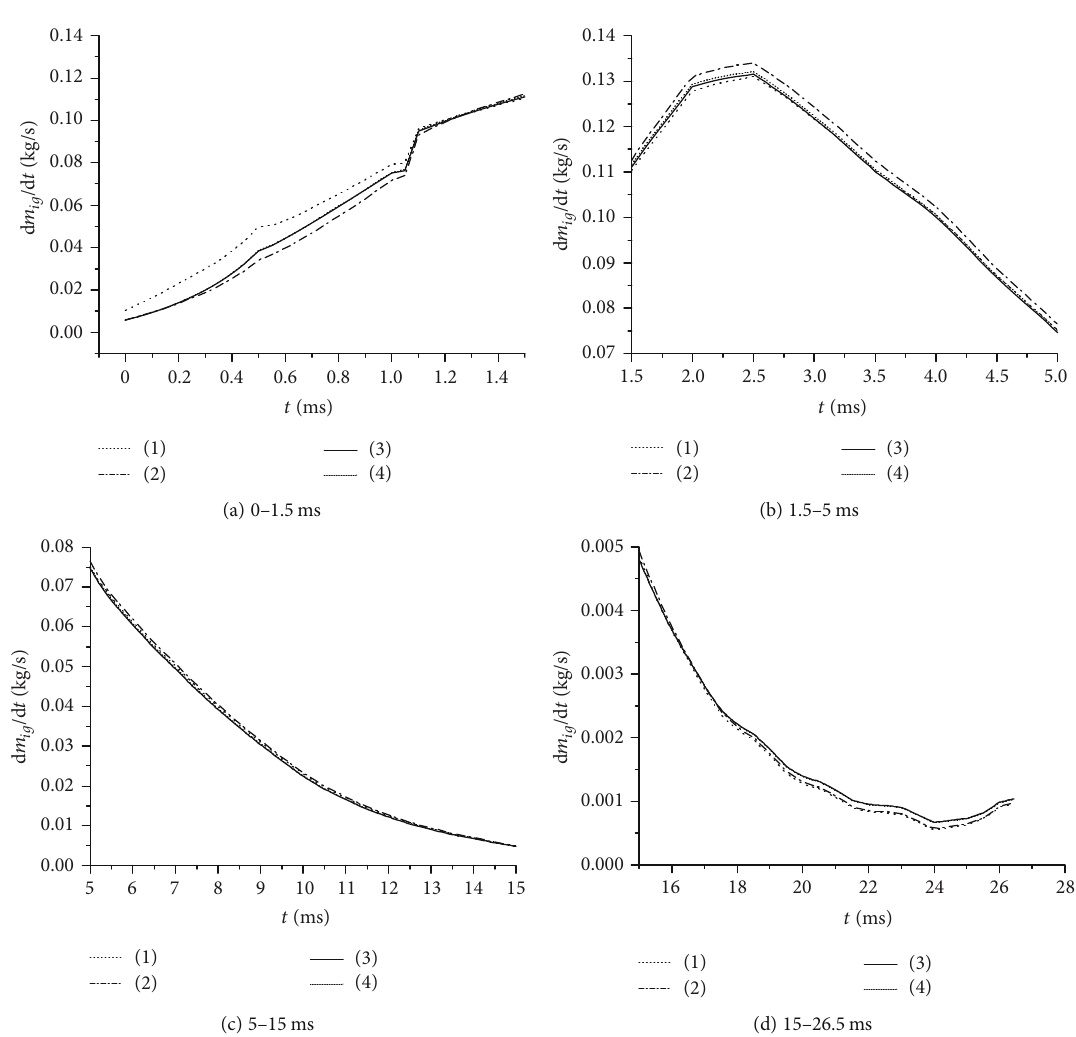
Figure 6: Details of the MFR history in di ff erent cases: (a) 0 – 1.5ms, (b) 1.5 – 5 ms, (c) 5 – 15ms, and (d) 15 – 26.5ms.